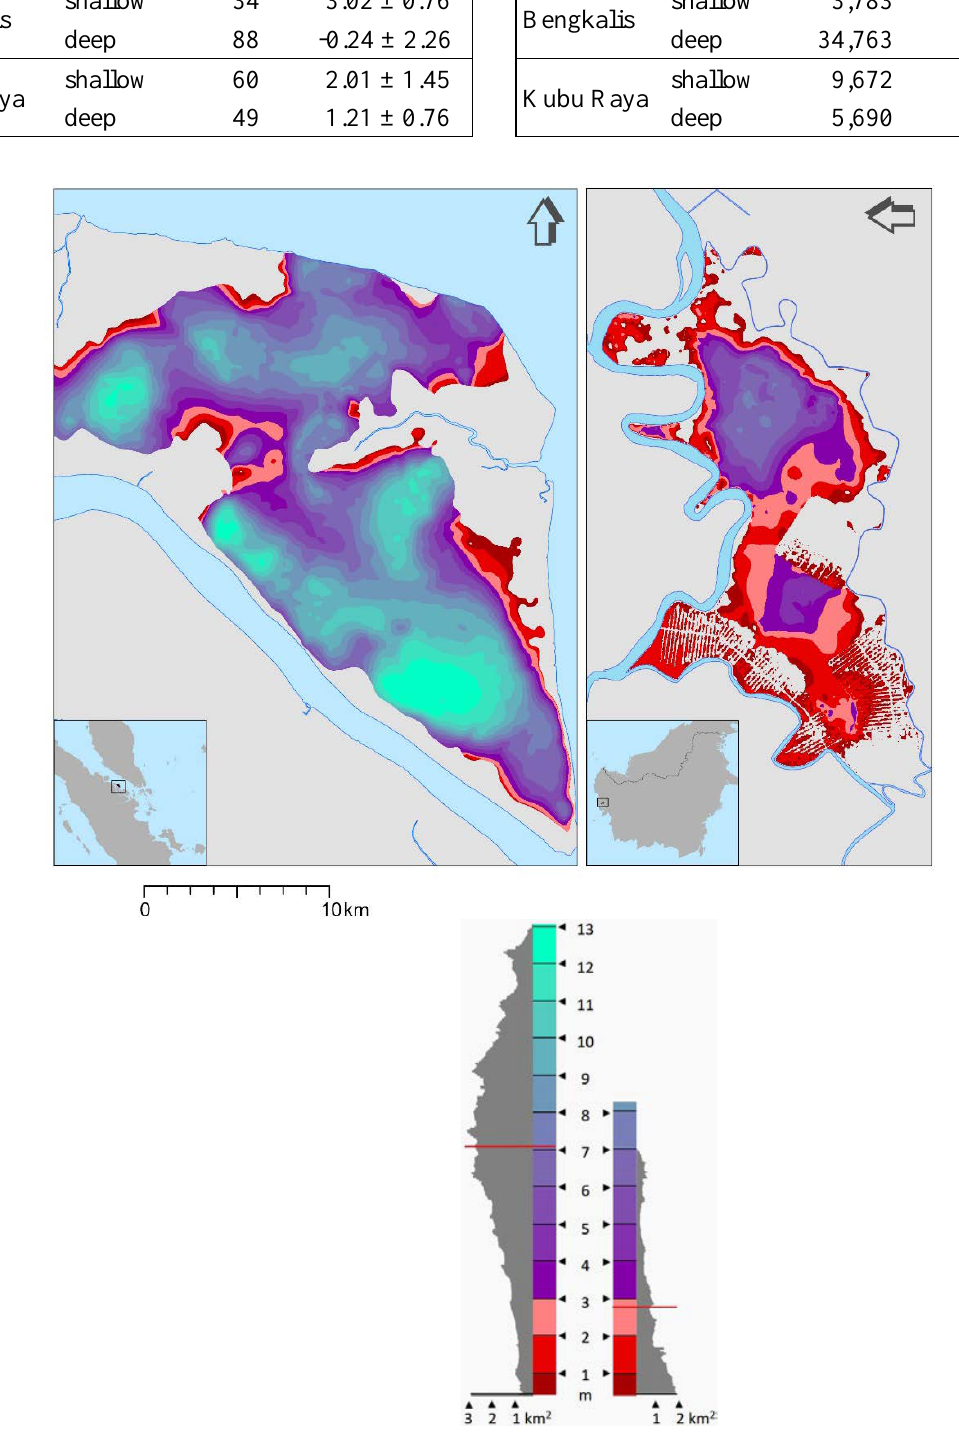
Figure 6. Peat thickness (m), peat extent at each thickness level (km 2 ) and mean thickness (red line) at Bengkalis (left) and Kubu Raya (right). At Kubu Raya, drainage, levelling and deflation have created a higher ratio of shallow peat to deep peat compared with